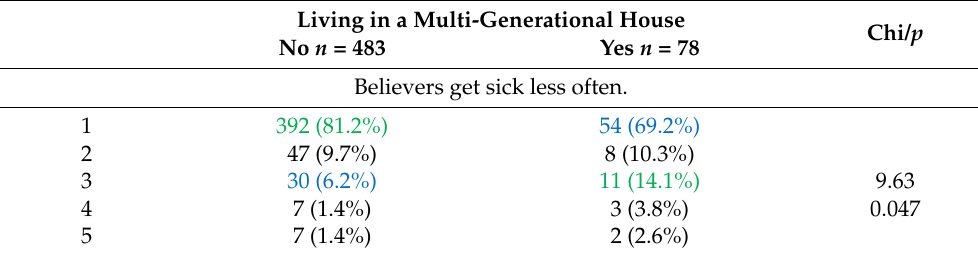
Table 4. Comparison of responses to questions about religion, the pandemic, and health issues in relation to living in a multi-generational